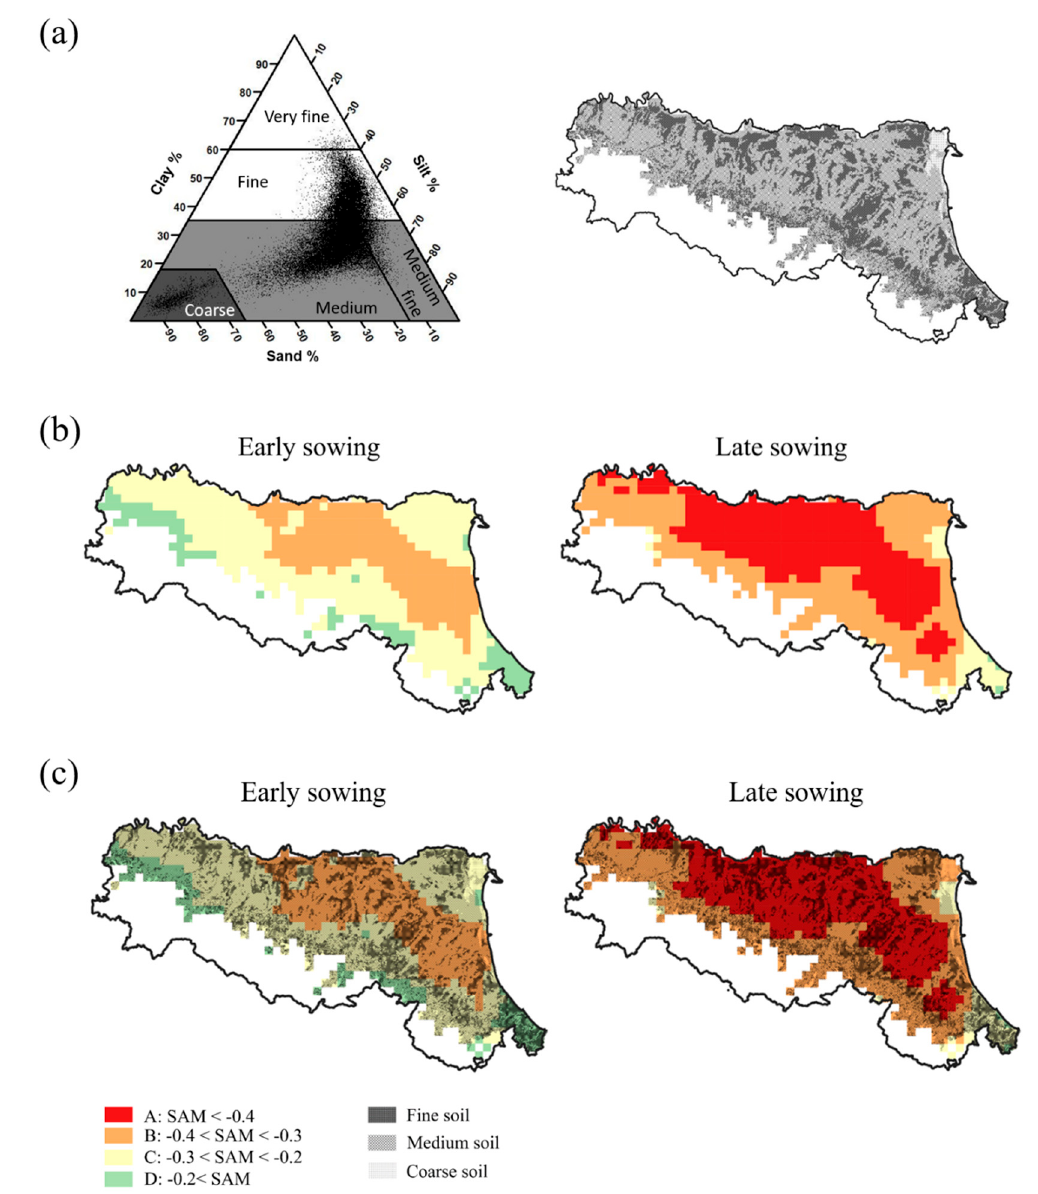
Figure 2. Characterization of the study area according to soil properties, climate features and management practices. ( a ) Soil zoning. Left panel: classification of soil texture. Fine and very fine: clay content >35% and sand content <65%; coarse: clay content <17.5% and sand content >65%; medium and medium-fine: all the remaining soils [27]. The classes very fine (VF) and fine (F) were combined together given the limited number of points in the VF class. The same criterion was used to combine the class medium (M) and medium-fine (MF). Right panel: final soil map. ( b ) Climate zoning. Maps of the Synthetic AgroMeteorological indicator (SAM; − 1 to + 1) calculated for each of the two main sowing periods (early sowing: 15th April; late sowing: 15th of May). ( c ) Final zonation. Daily weather data from 2009 to 2018 were retrieved from the high-resolution (5 km × 5 km) gridded climate dataset available at the Regional Agency for Prevention, Environment and Energy of the Emilia-Romagna website (ARPAE), which is based on 60 weather stations for temperature and 254 for rainfall [28]. Overall, the study area consists of 679 cells of 5 km × 5 km. For each of them, global − 2 − 1 − 1 solar radiation (RAD, MJ m d ) and reference evapotranspiration (ET0, mm d ) were derived by using the approaches reported by